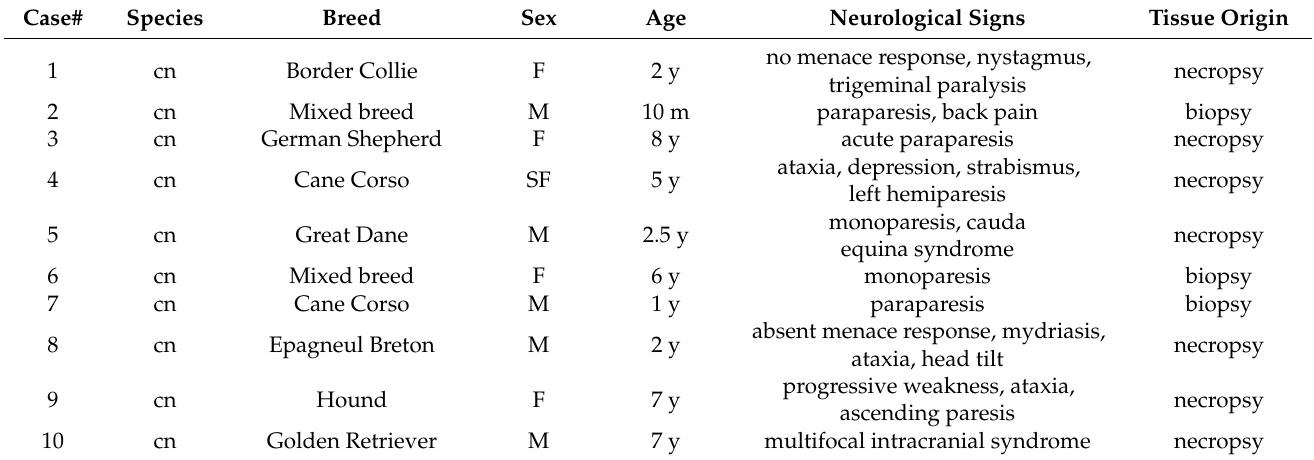
Table 1. Signalment, main neurological signs, and tissue sample origin of 92 cases of canine and feline central and peripheral nervous system